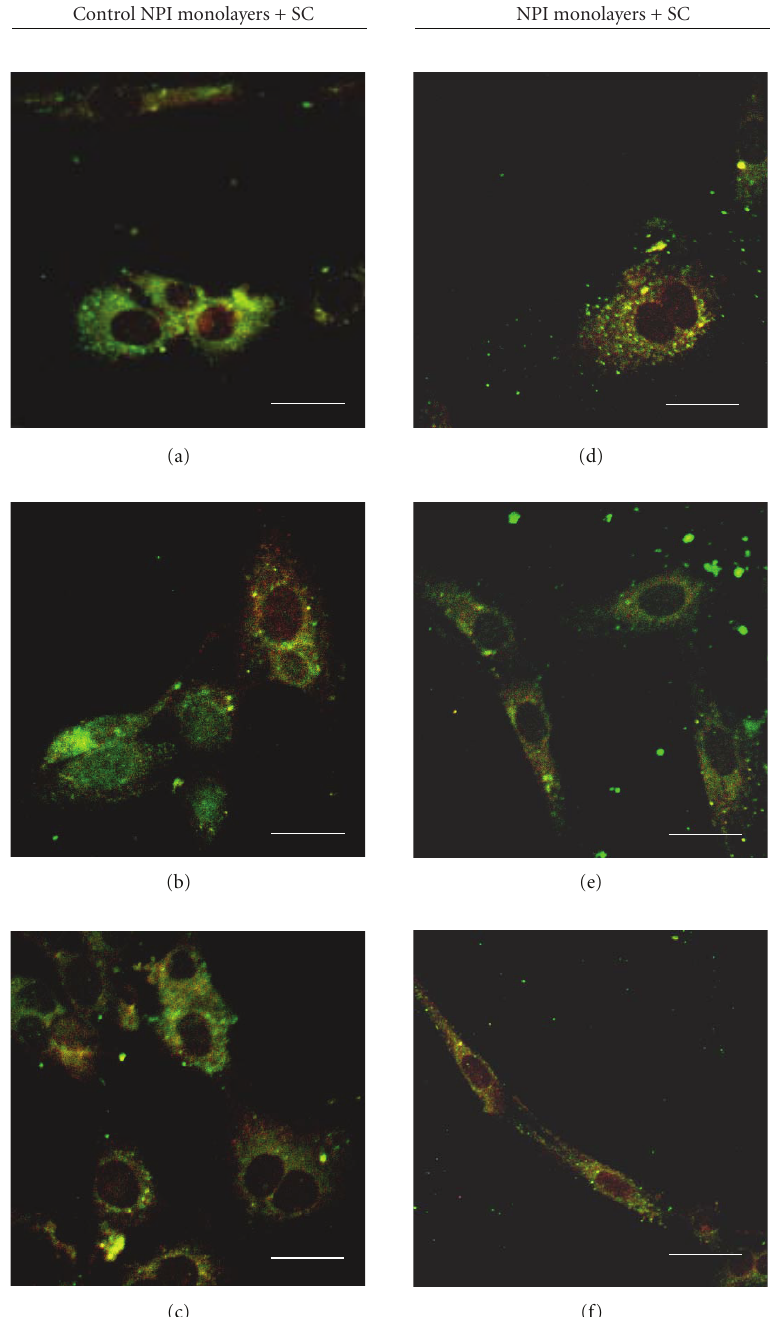
Figure 7: Double fluorescence immunolabeling (green signal: anti-c-kit Ab; red signal anti-insulin Ab) under confocal laser microscopy of NPI cell monolayers cultivated for 7 (a), (d), 14 (b), (e), and 21 (c), (f) days, alone (a)–(c) or with SC (d)–(f). Bar = 10 μ